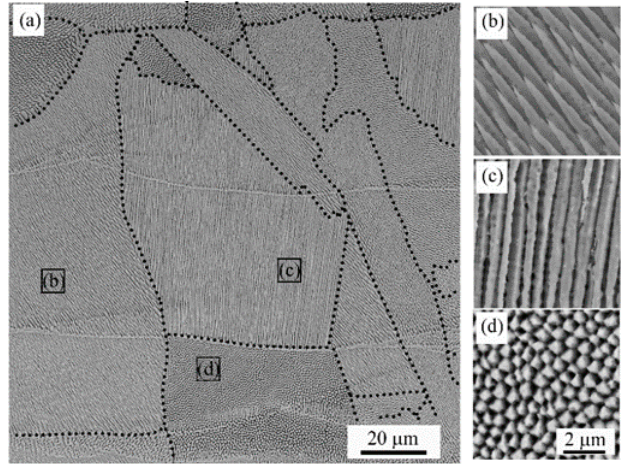
Figure 1. The substructure in the cubic sample. ( a ) Low magnification. ( b – d ) High magnification. The boundaries of the colonies are marked out by the black dotted line. ( b ) The substructure is inclined to the section. ( c ) The substructure is parallel the section. ( d ) The substructure is perpendicular to the section.